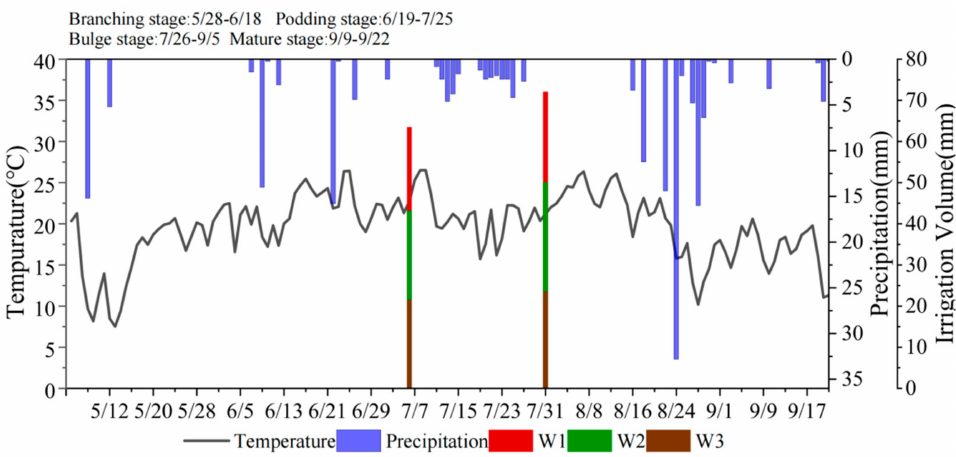
Figure 2. Precipitation and temperature during co-growth period of the apple and soybean. Notes: W1, W2, and W3 are the irrigation volumes for the three irrigation gradients; all meteorological data are for the year